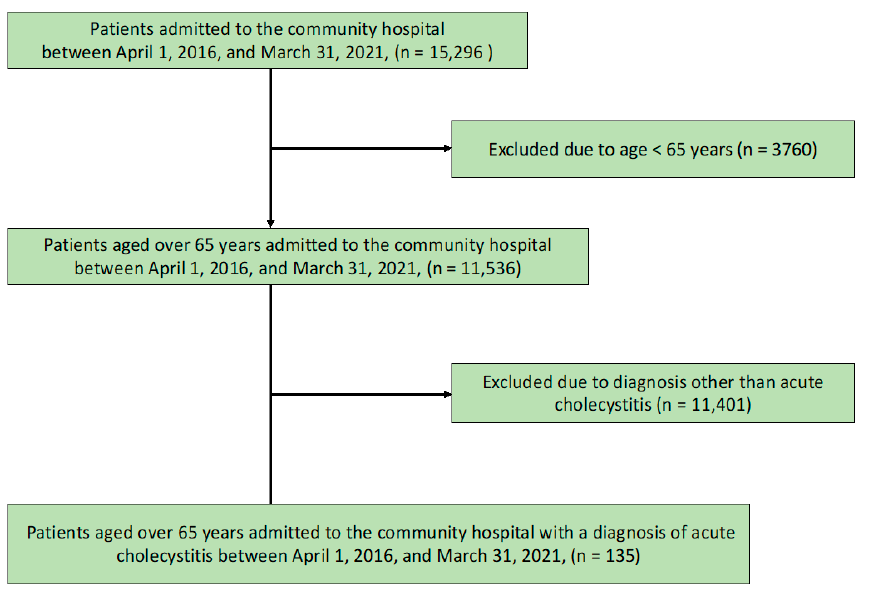
Figure 1. Flow chart showing the participant selection process. The average ages of the control and exposure groups were 77.71 years (standard deviation [SD] = 14.62) and 80.13 years (SD = 13.95), respectively. The proportions of men in the control and exposure groups were 41.7% and 64.1%, respectively. Between the control and exposure groups, male sex, BMI, total FIM score, presence of abdominal pain, and serum albumin level showed statistically significant differences (Table 1).